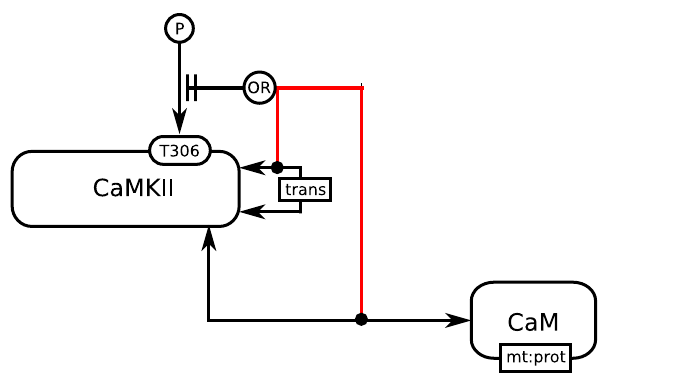
Figure 2.31: In this example, two logic arcs reflect the fact that the phosphorylation of threonine 306 on CaMKII is precluded either by a dimerisation or the binding of